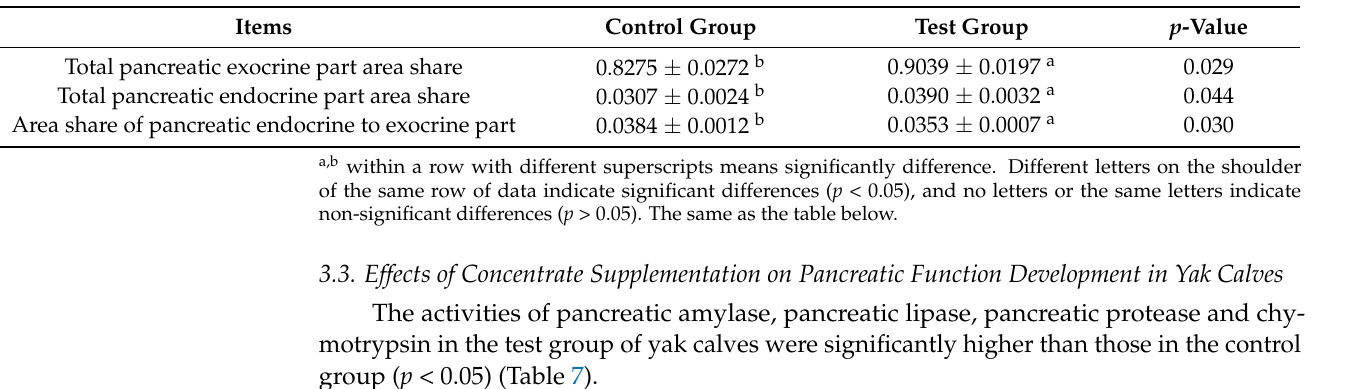
Table 6. Effect of concentrate supplementation on the area of internal and external secretion of pancreas in yak calves (Unit: %).